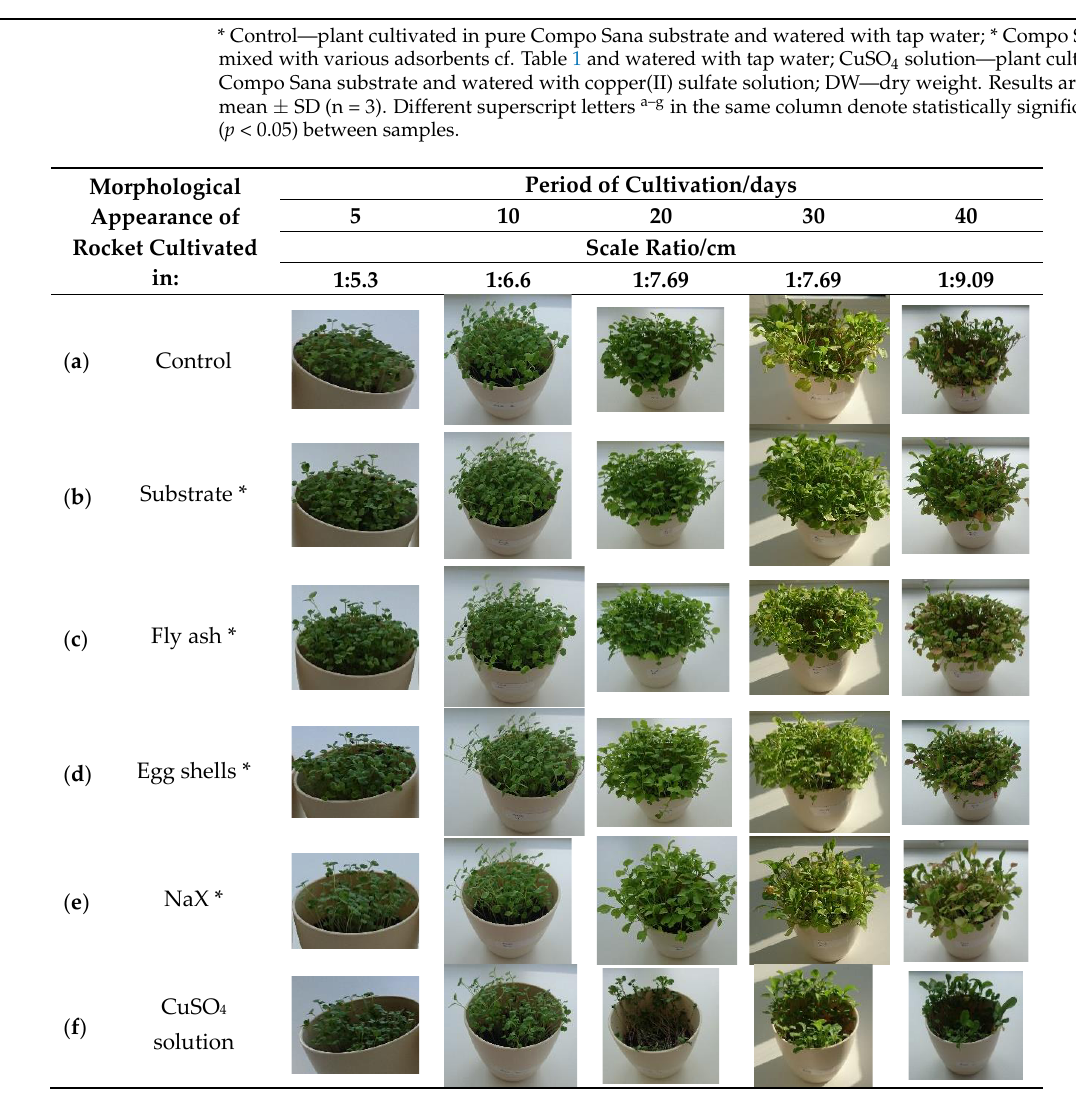
Figure 1. Morphological appearance of the rocket ( Eruca vesicaria (L.) Cav.) cultivated in differently